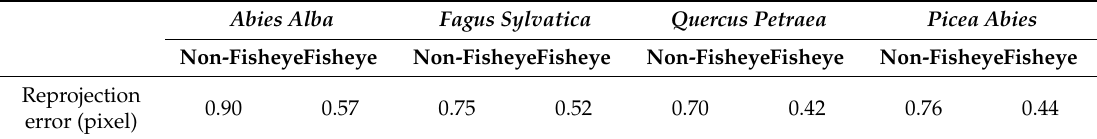
Table 5. The average of reprojection error of both lenses that were used divided by tree